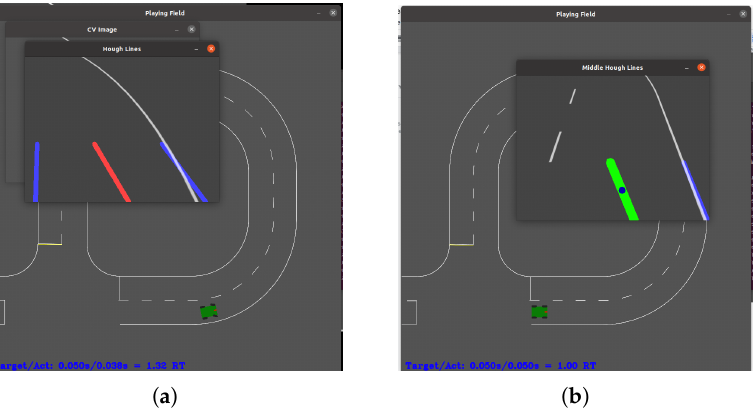
Figure 13. The Hough Lines and the Center Lane Line are visually represented in 2D simulation: ( a ) Average middle line lane; ( b ) Offset right